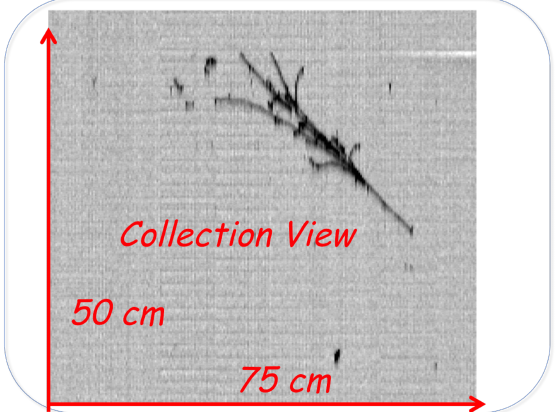
Figure 3. A quasi-elastic atmospheric electron neutrino interaction with a deposited energy of 0.4 GeV is shown in the 2D collection view of ICARUS-T600. The dE/dx in the first 2.5 cm of the shower results in ∼ 2 MeV/cm, fully compatible with an m.i.p., as expected for an electron